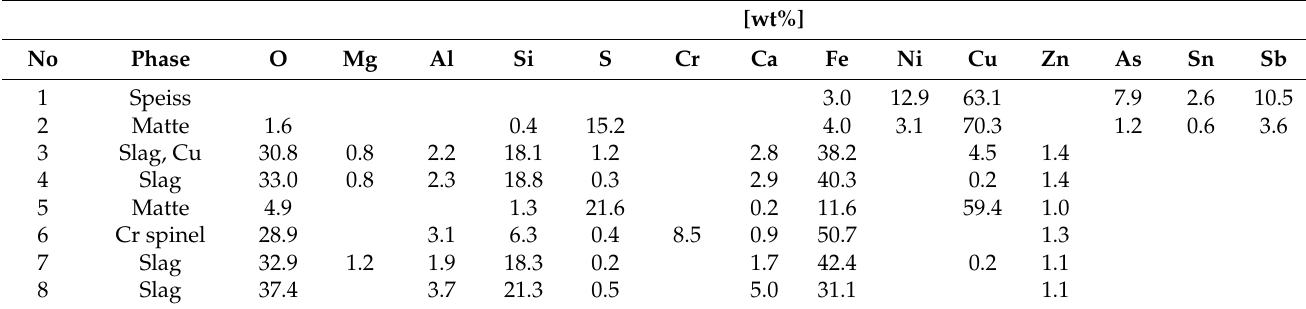
Table 5. Normalized EDS point analysis of samples collected at the settling start and end for T1, phases from Figure 4a,b.